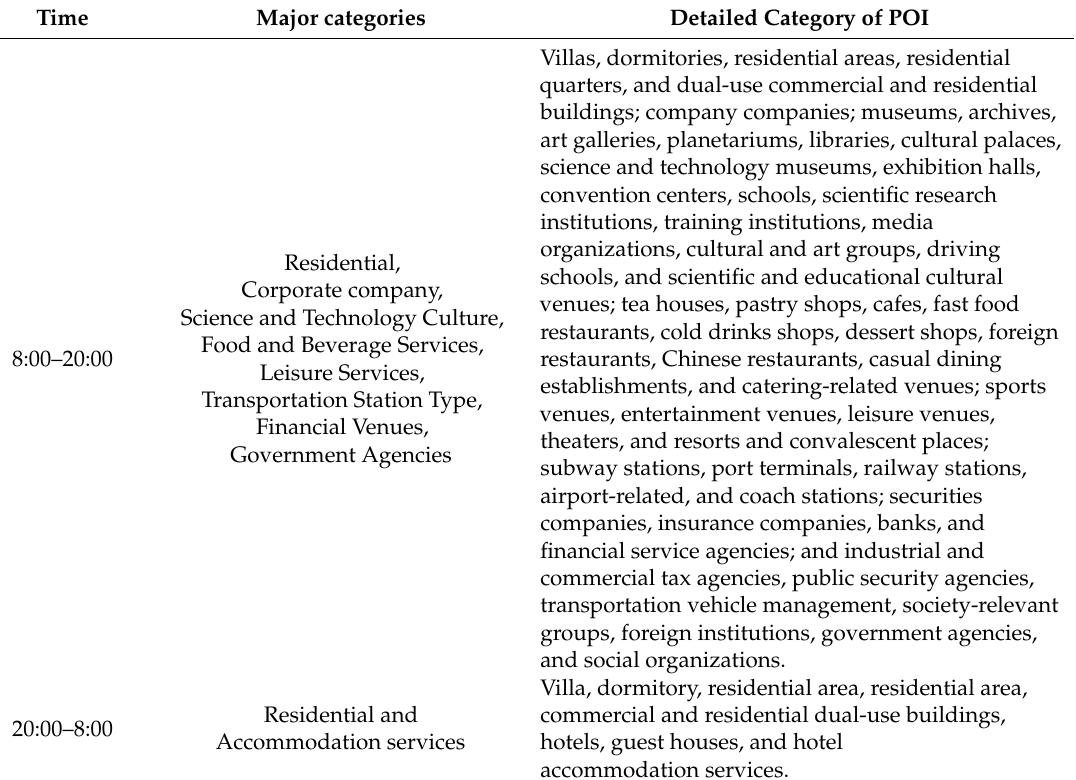
Table 1. The main places of activities for urban residents in di ff erent periods. POI: point of interest.